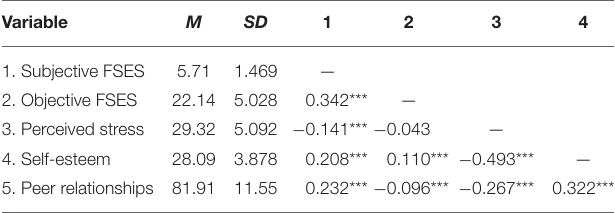
TABLE 1 | Means, standard deviations, and correlations.